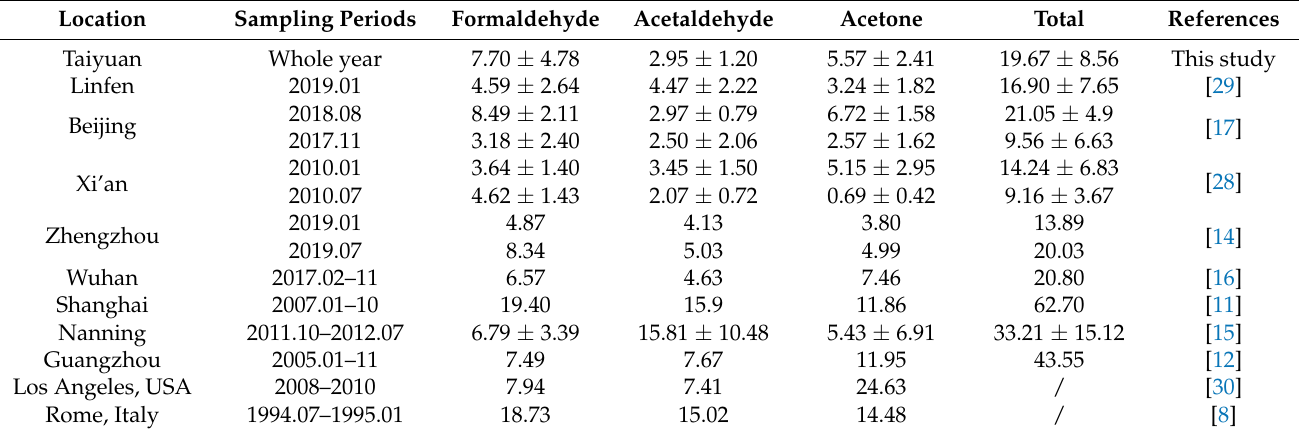
Table 1. Comparison of atmospheric formaldehyde, acetaldehyde, acetone and total carbonyls in Taiyuan and other cities in the world ( µ g/m 3